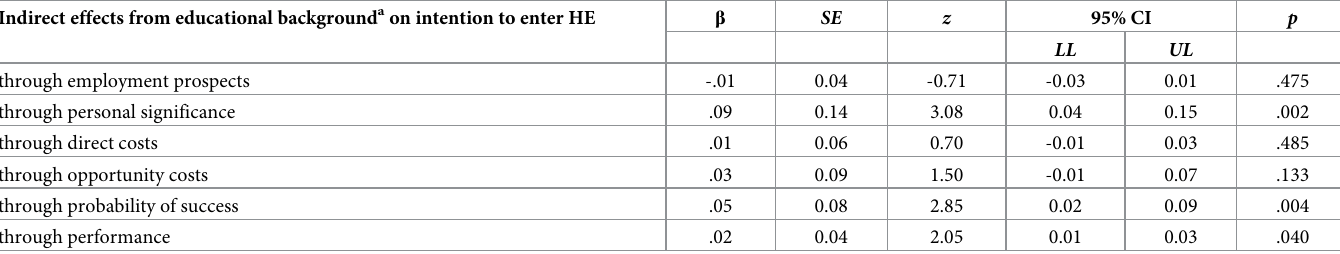
Table 2. Indirect effects from educational background on intention to enter HE through rational choice patterns and academic performance. Indirect effects from educational background a on intention to enter